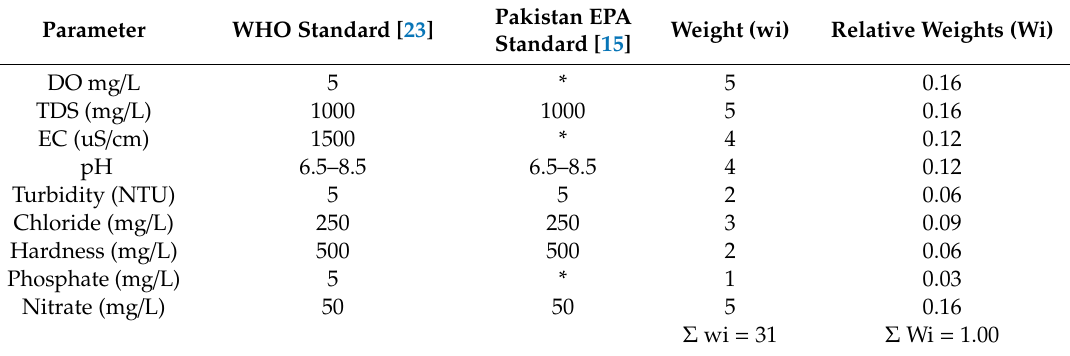
Table 2. Raw and relative weights for each water quality parameters [14,18,20,32].